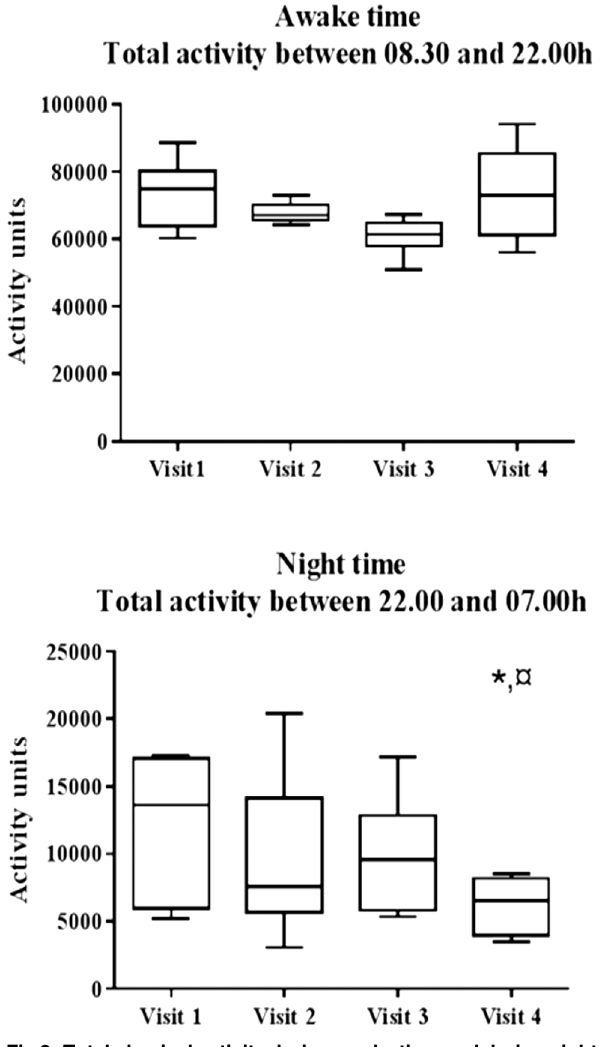
Fig 2. Total physical activity during awake time and during night time analyzed by three-axial accelerometers (Actigraph GT3X+) in six female subjects before and during weight loss (10 days and 3 months postoperatively) and at weight stability 20 months after gastric bypass surgery. * ; significant difference to visit 1; * = p < 0.05. ¤ ; significant difference to visit 3; ¤ = p <